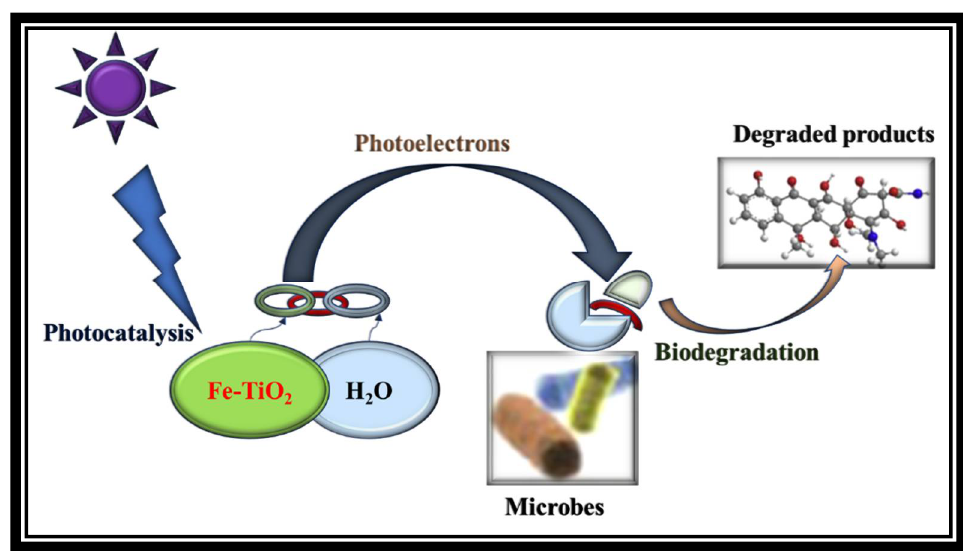
Figure 5. A schematic diagram of the biophotocatalytic system degradation mechanism